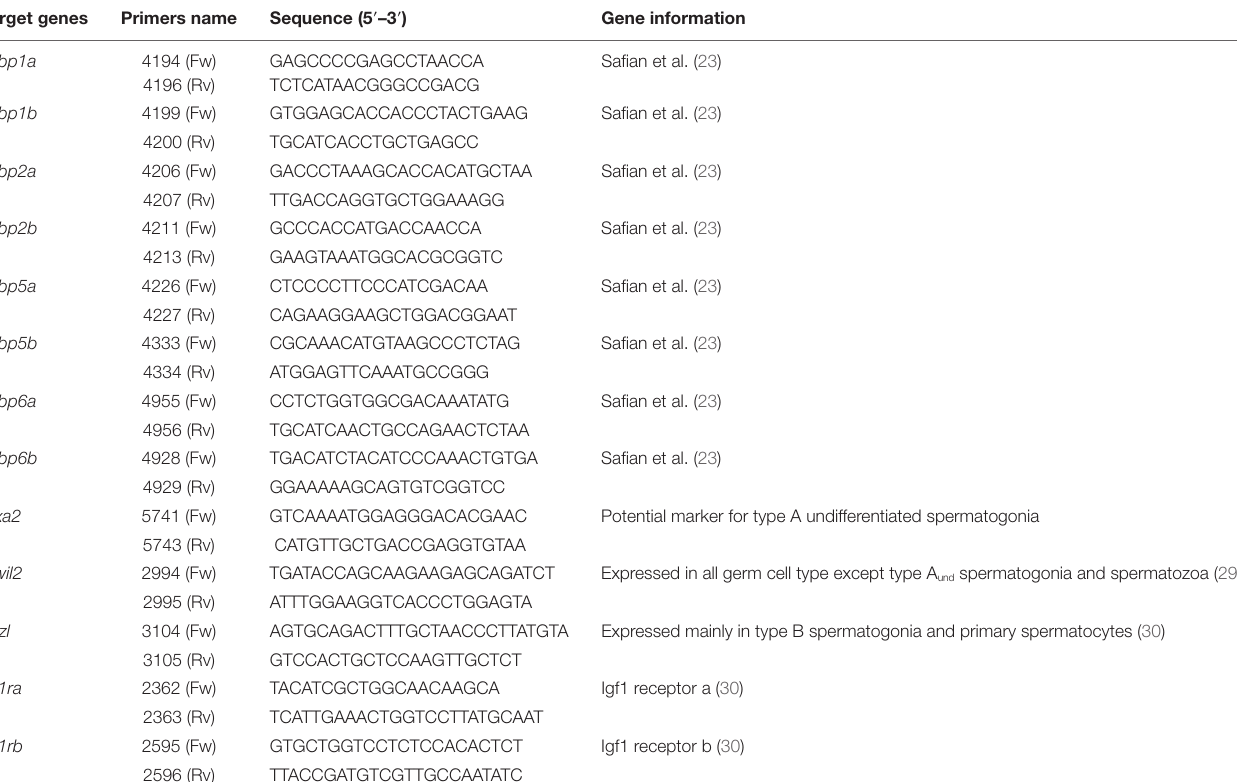
Table 1 | Primers used for gene expression